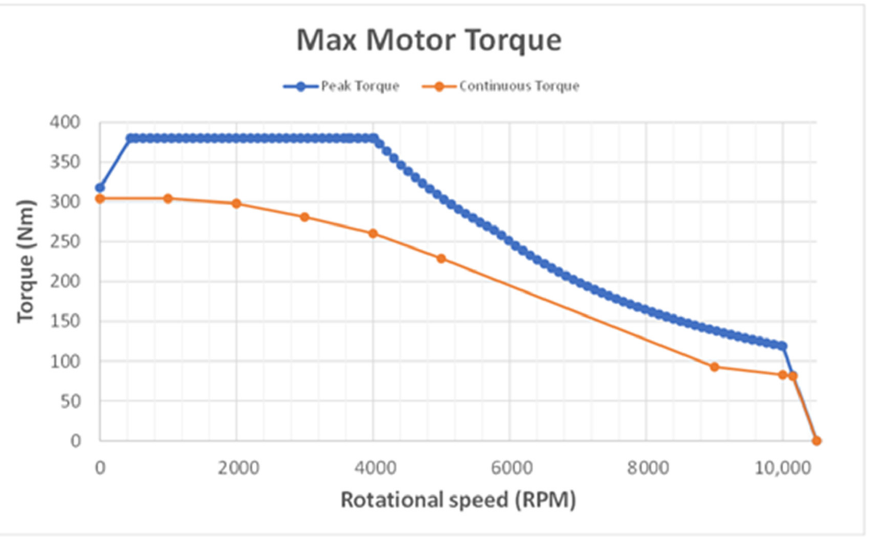
Figure 5. Peak torque and the continuous torque of the traction motor vs. the speed of rotation of the electric motor itself (in RPM).